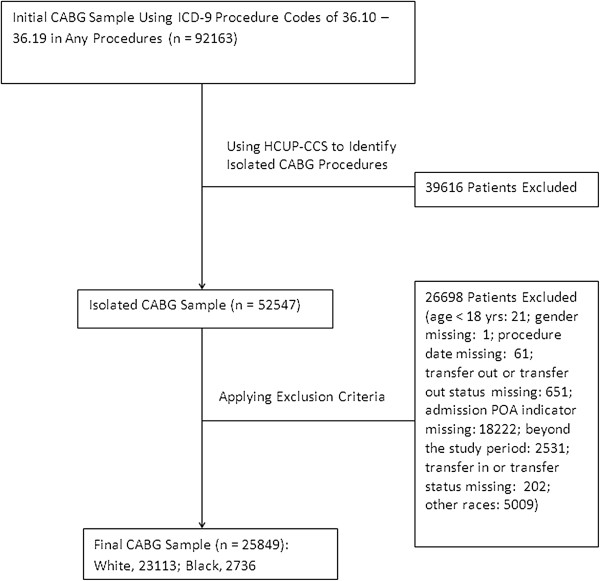
Flow chart for CABG sampling.